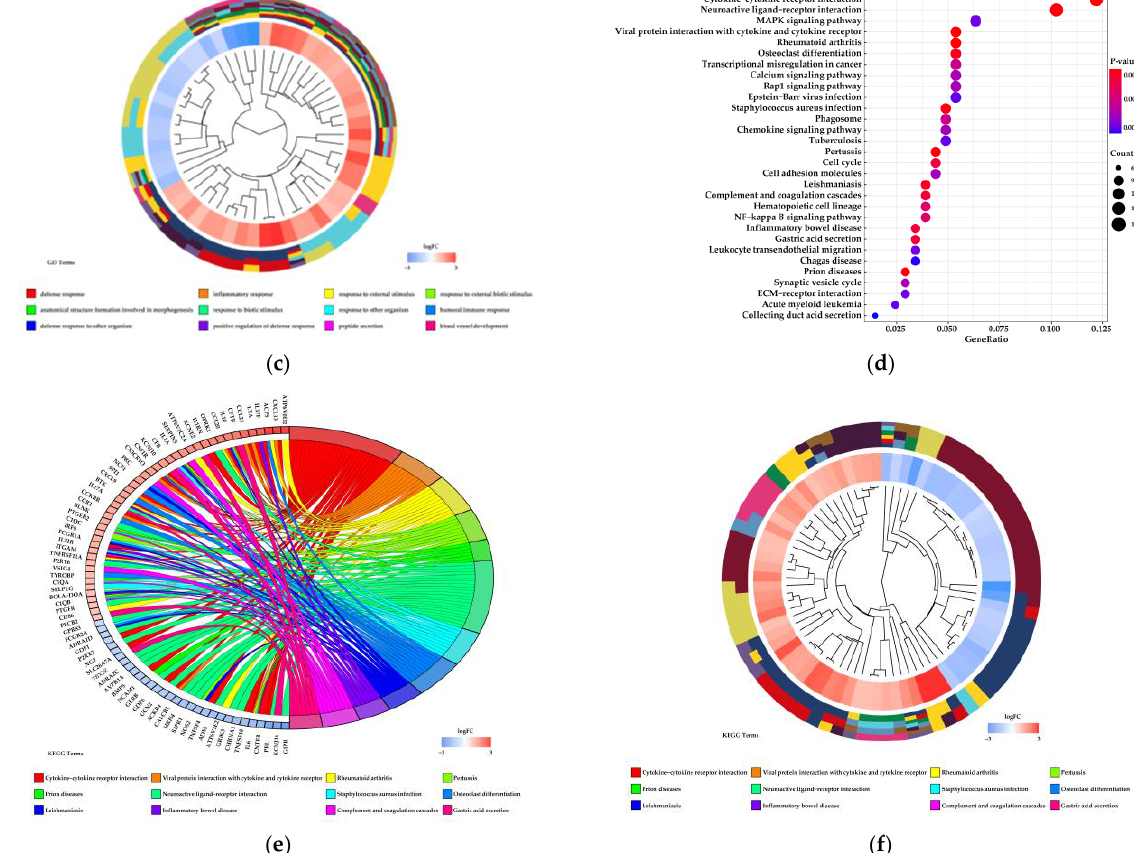
Figure 3. Significant gene ontology (GO) terms and Kyoto Encyclopedia of Genes and Genomes (KEGG) pathways of DEGs. ( a ) The top 10 significant GO terms are respectively listed in each catalog, including biological process (BP), cellular component (CC) and molecular function (MF). ( b ) Circos plots show specific responses and overlapping of DEGs enriched in the top 12 significant GO terms. ( c ) Circos plots indicate features of DEGs enriched in the top 12 significant GO terms. ( d ) The top 30 significant KEGG pathways of DEGs. ( e ) Circos plots show specific responses and overlapping of DEGs enriched in the top 12 significant KEGG pathways. ( f ) Circos plots indicate the features of DEGs enriched in the top 12 significant KEGG pathways.